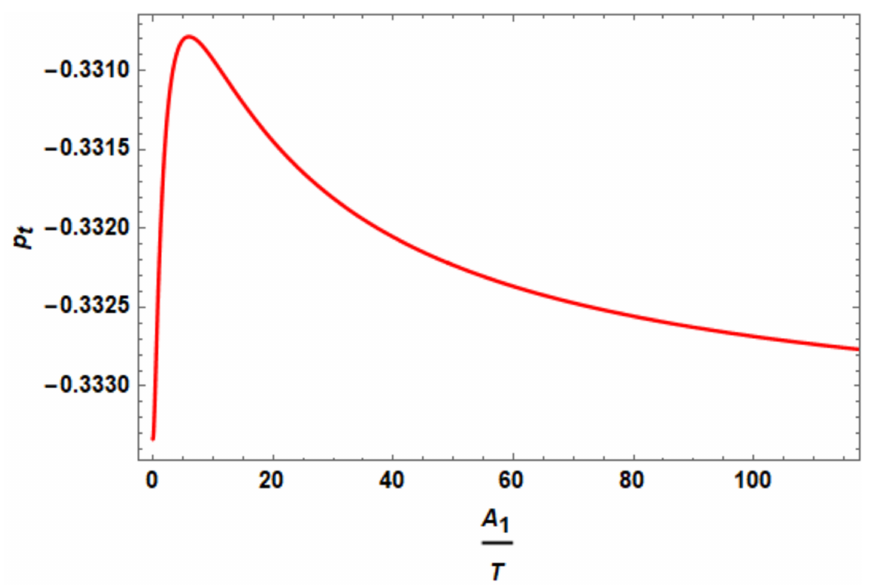
Figure 3. Plot showing how Kasner exponent p t changes with deformation A 1